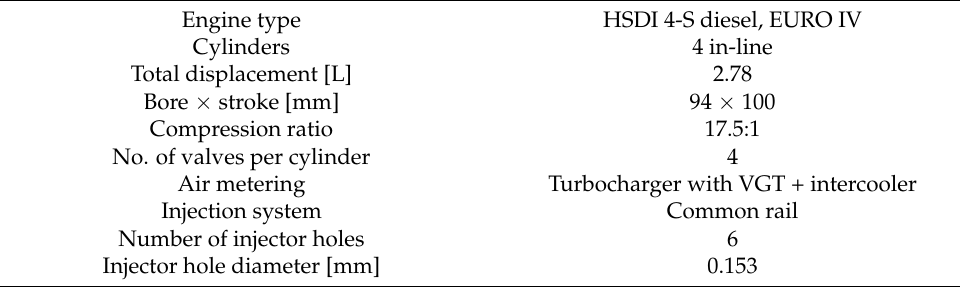
Table 3. Main technical data of the reference diesel